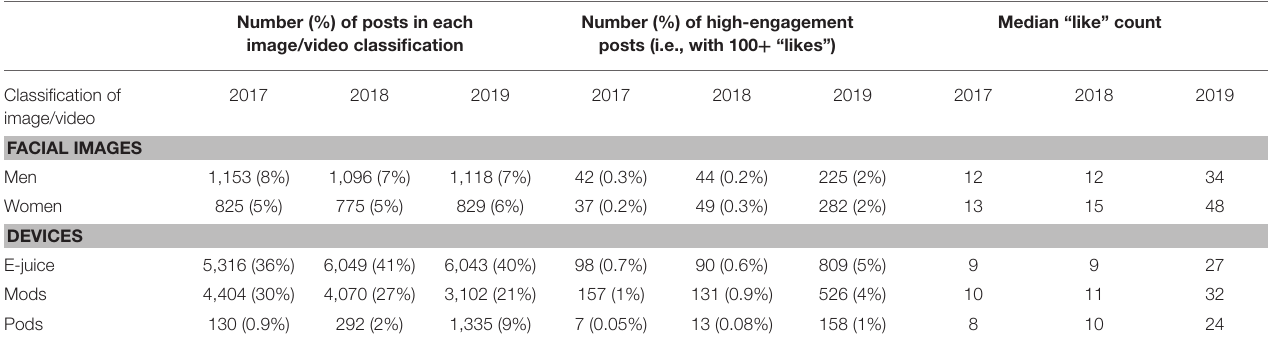
TABLE 1 | Predicted deep learning image classification for Instagram posts using #ejuice or #eliquid collected in 2017 ( N = 14,810), 2018 ( N = 14,907), and 2019 ( N = 14,982). Number (%) of posts in each image/video classification